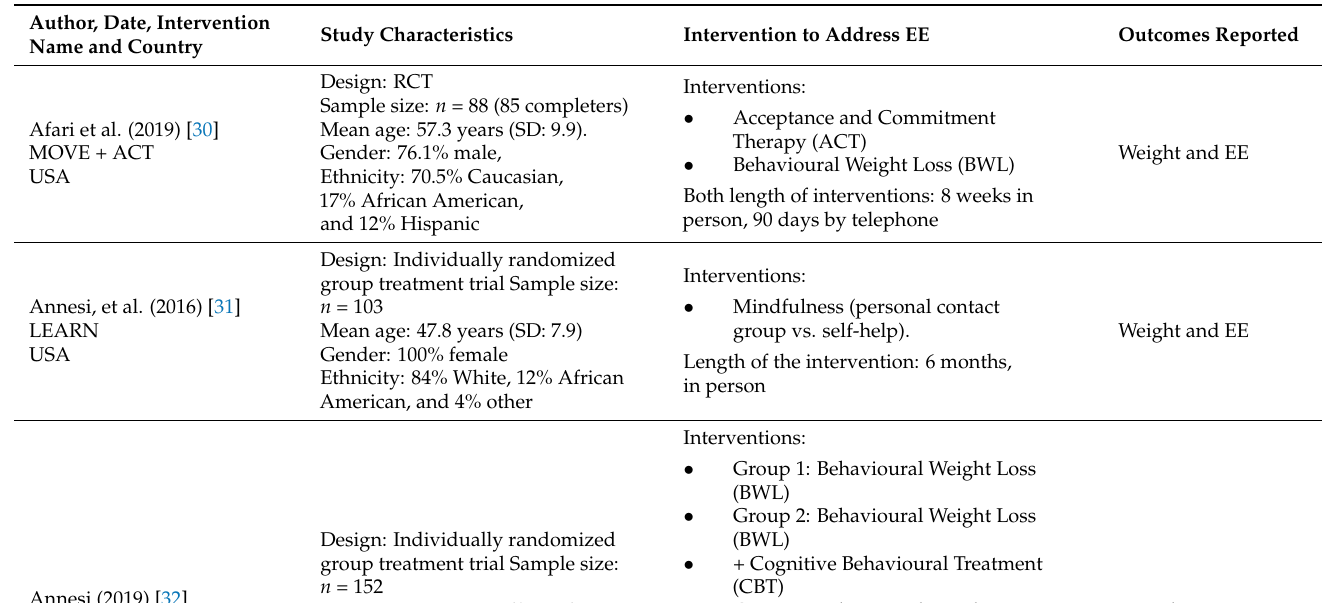
Table 2. Summary of included